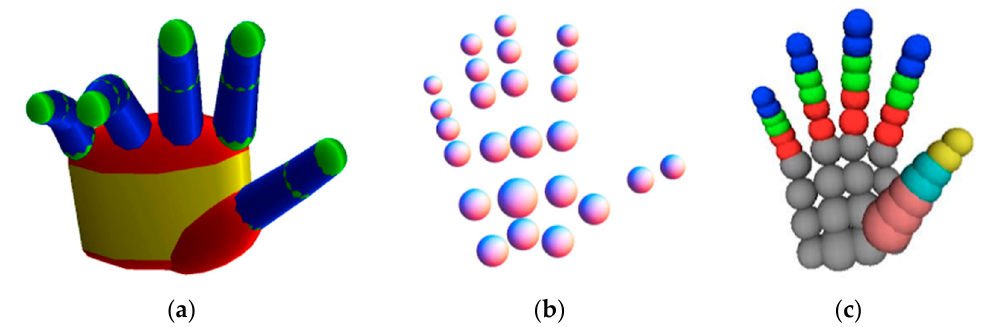
Figure 7. Hand models made of geometric primitives. ( a ) The hand model consisting of color-coded geometric primitives (yellow: elliptic cylinders, red: ellipsoids, green: spheres, blue: cones) [64]. ( b ) The hand’s collision model consisting of 25 spheres [64]. ( c ) Hand model using 48 spheres